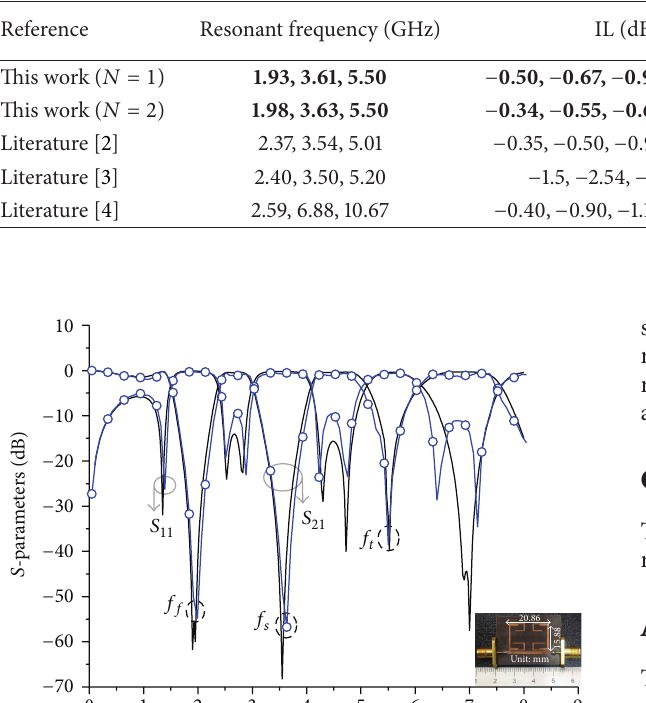
Table 2: Performance comparison of reported TBBSFs.